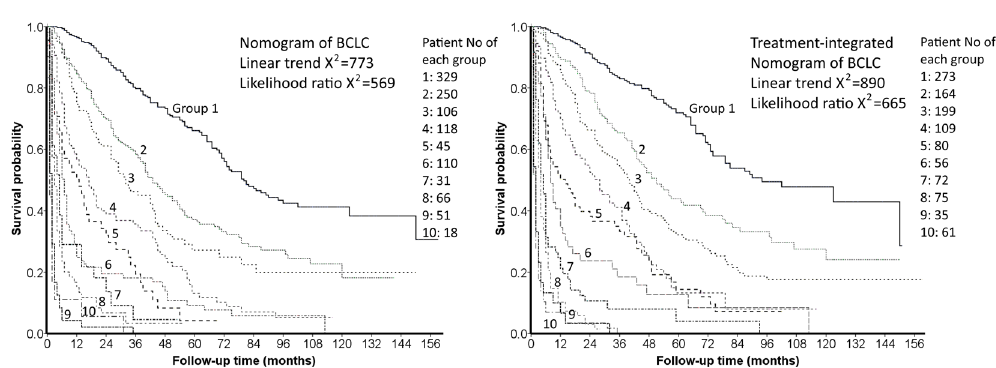
Figure 6. Patients from validation set were divided into 10 subgroups by one-tenth of total nomogram point (2.6 and 3 for the nomogram of original BCLC and the treatment-integrated nomogram, respectively). Compared to the nomogram of original BCLC system, the treatment-integrated nomogram has larger linear trend X 2 and likelihood ratio X 2